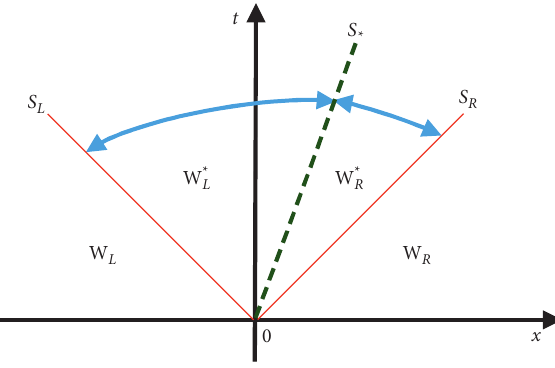
Figure 1: The structure of the HLLC Riemann